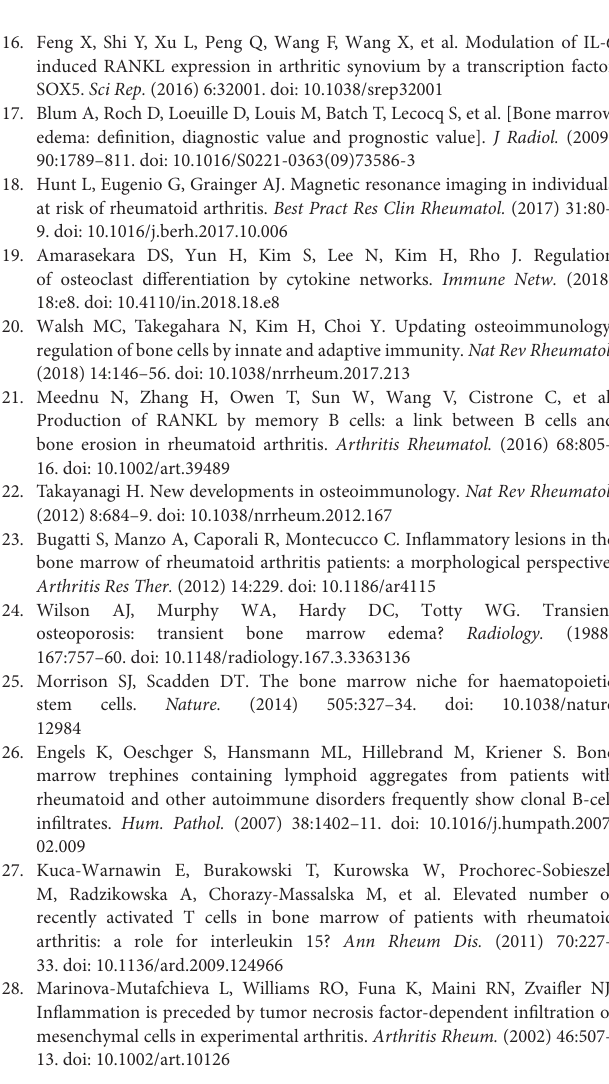
Figure S1 | The changes in the composition of bone marrow detected different myeloid markers during indicated time point of CIA development. A. Ly6C and B. F4/80.